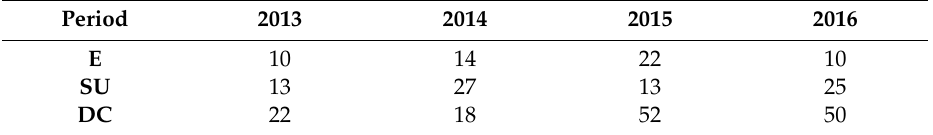
Table 3. Enterococcus concentrations (MPN / 100 mL) in surface seawater at La Boquita beach during